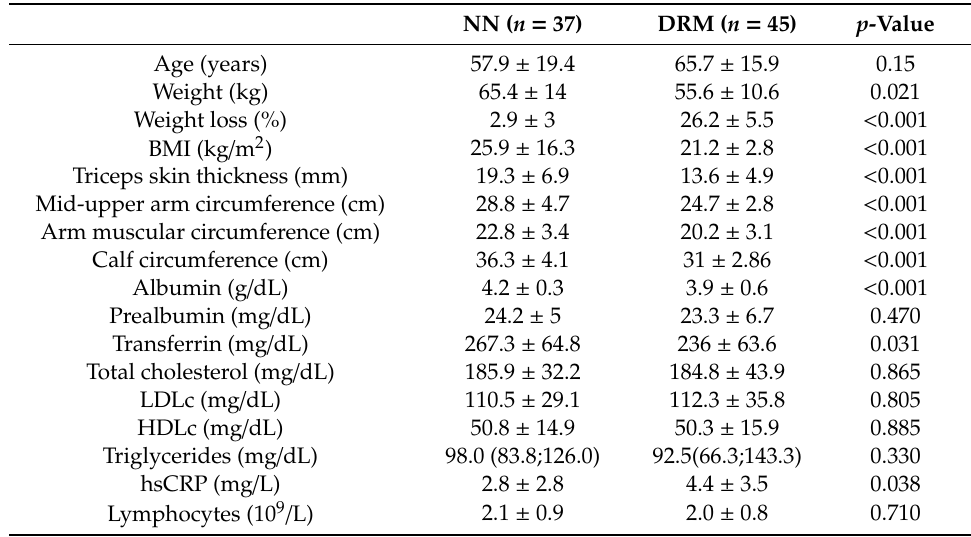
Comparison of anthropometrical, biochemical, and metabolic parameters between normonourished and disease-related malnutrition